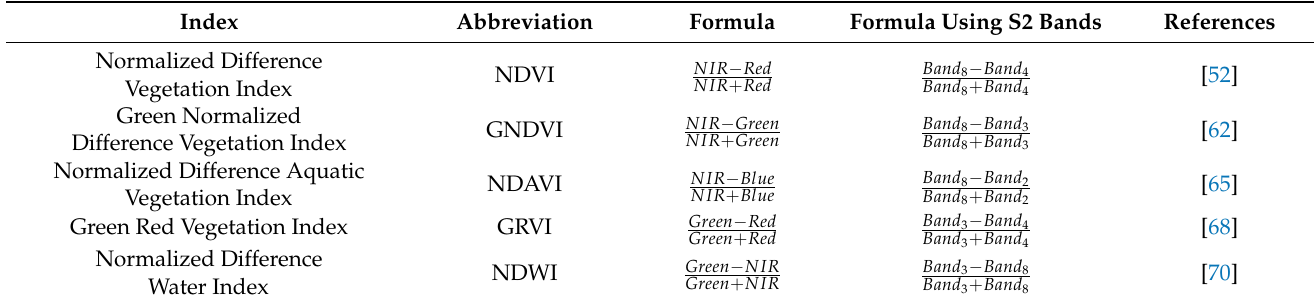
Table 3. Sentinel-2 (S2) spectral bands and definition of vegetation and water